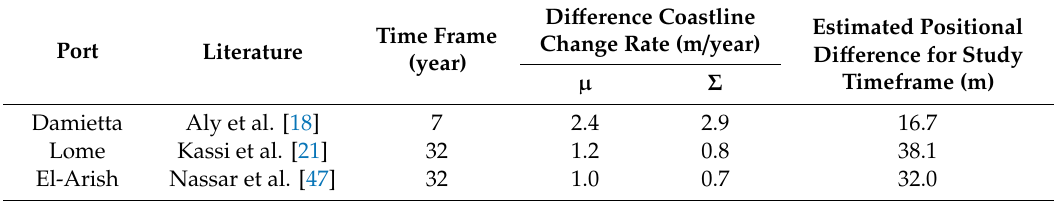
Table 8. Overview of the di ff erences in coastline change rates (m / year) between literature and our study for the ports of Damietta (Egypt), Lom é (Togo) and El-Arish (Egypt). The di ff erences are expressed in the mean ( µ ) and standard deviation ( σ ) of the coastline change rates over all transects as well as the estimated (mean) di ff erence in coastline position over the study time